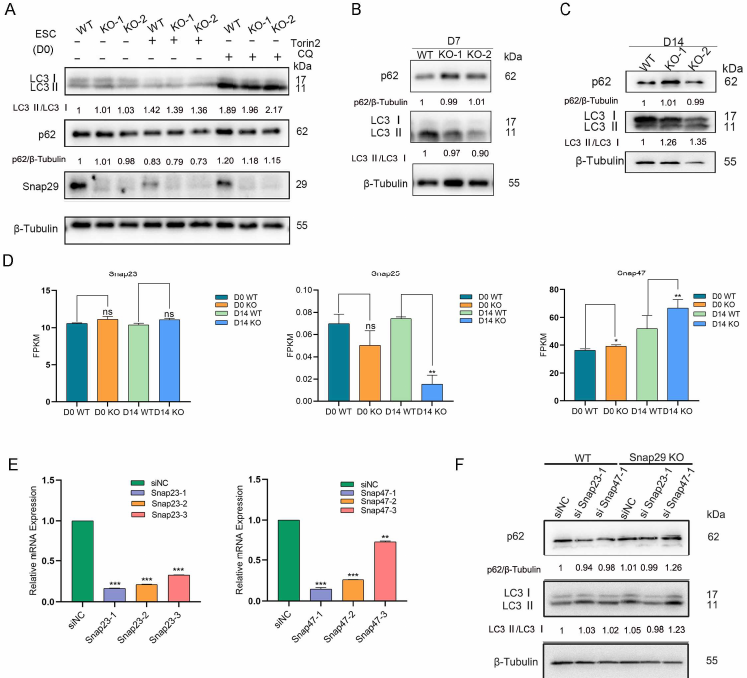
Figure 6. Snap29 deficiency does not lead to impaired autophagy in ESCs and differentiated cells. ( A ) Western blot analysis of LC3 I/II and p62 levels in Snap29 +/+ and Snap29 − / − ESCs. Torin2 (200 nM) and chloroquine (CQ, 50 µ M) were used for 6 h to induce or block autophagic flux, respec- tively. ( B ) Western blot analysis of LC3 I/II and p62 levels in Snap29 +/+ and Snap29 − / − differentiated cells at day 7. ( C ) Western blot analysis of LC3 I/II and p62 levels in Snap29 +/+ and Snap29 − /